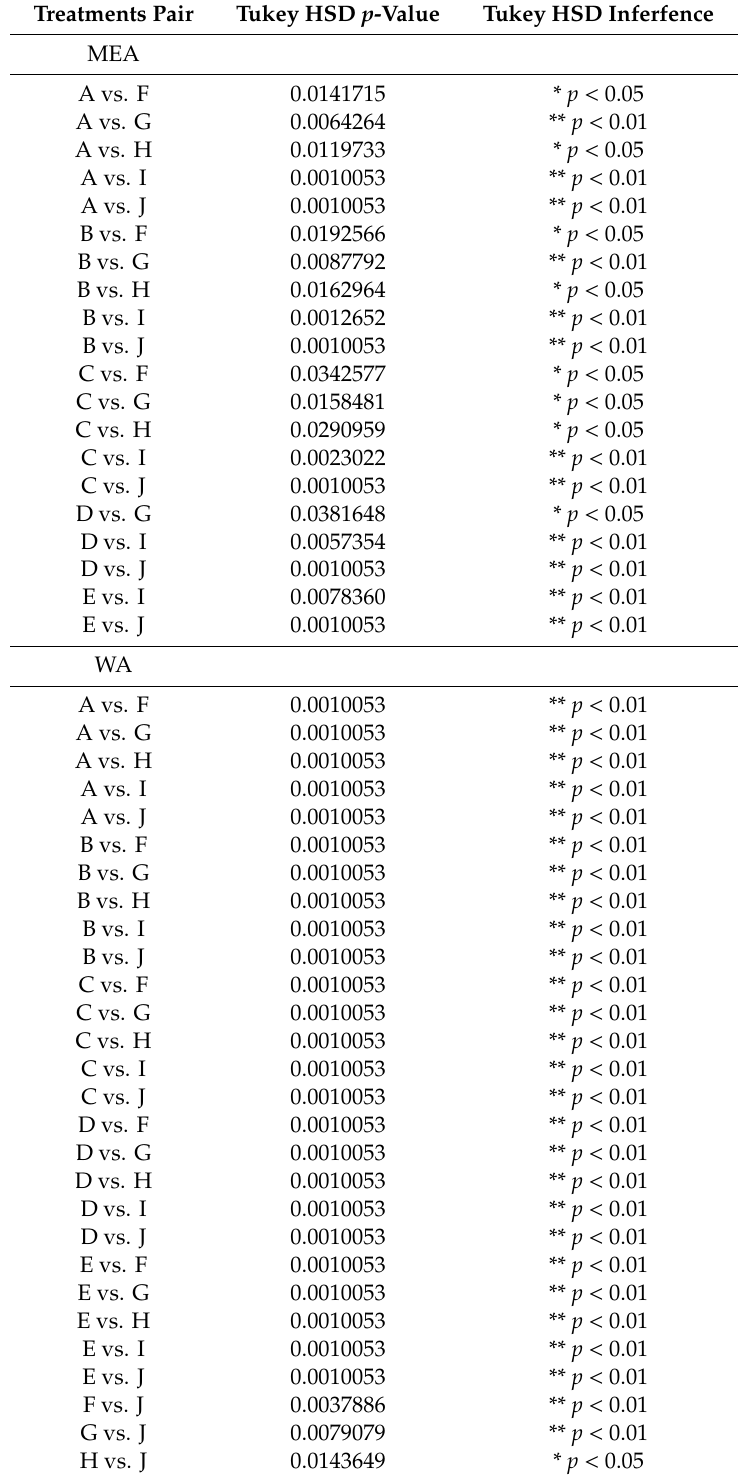
Table 9. Significant di ff erences among unfiltered wine samples for individual cultivation